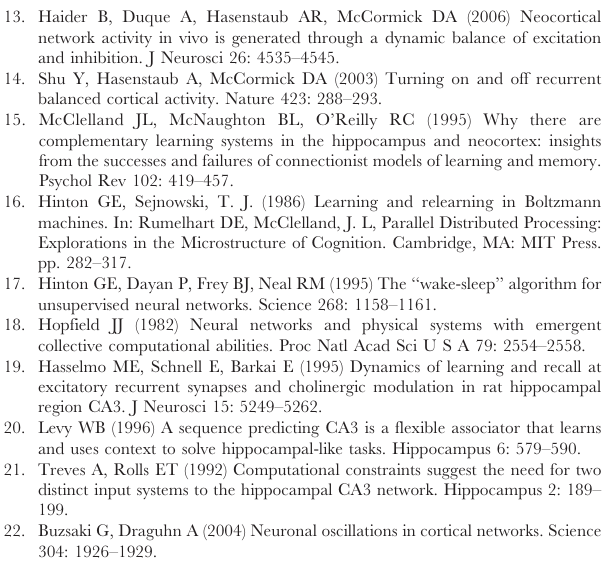
Figure S3 Learning accuracy as a fraction of active pruning of a fraction of synapses. The weights of the weakest